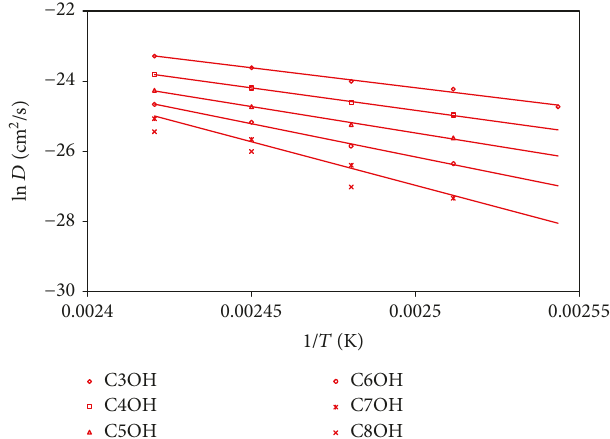
Figure 5: Correlation between the reciprocal temperature and the logarithm of the di ff usion coe ffi cient D investigated